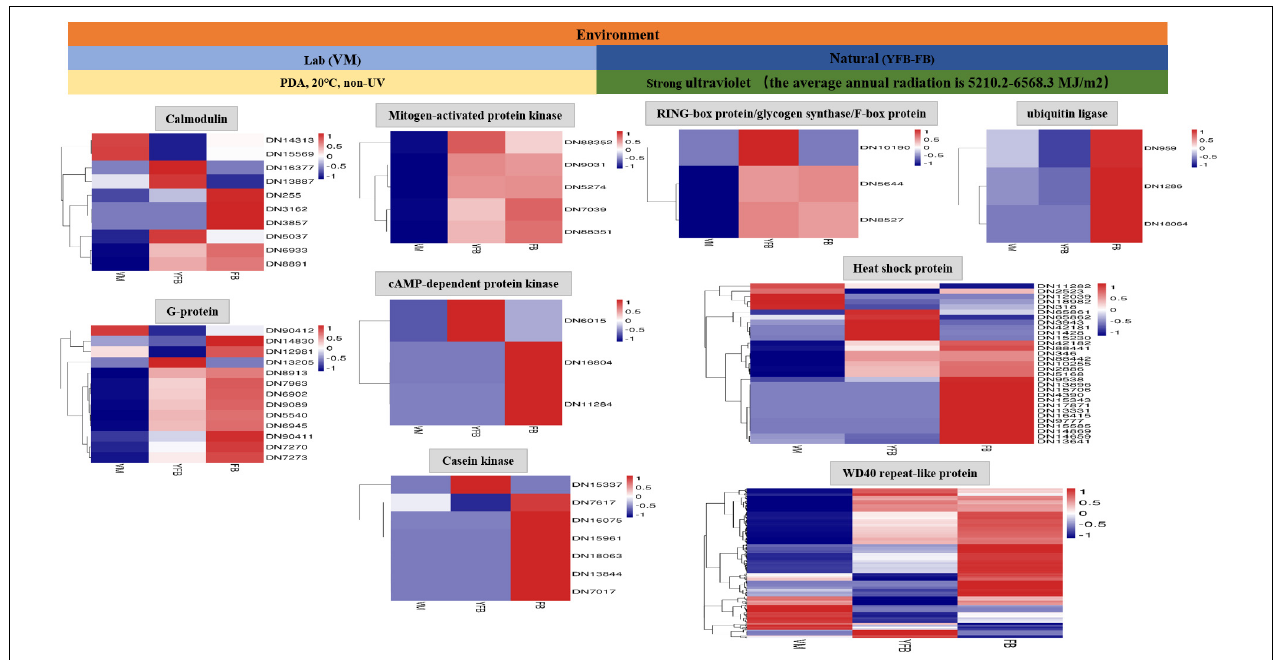
FIGURE 3 | The 255 differential genes were annotated in response to UV radiation of F. luteovirens